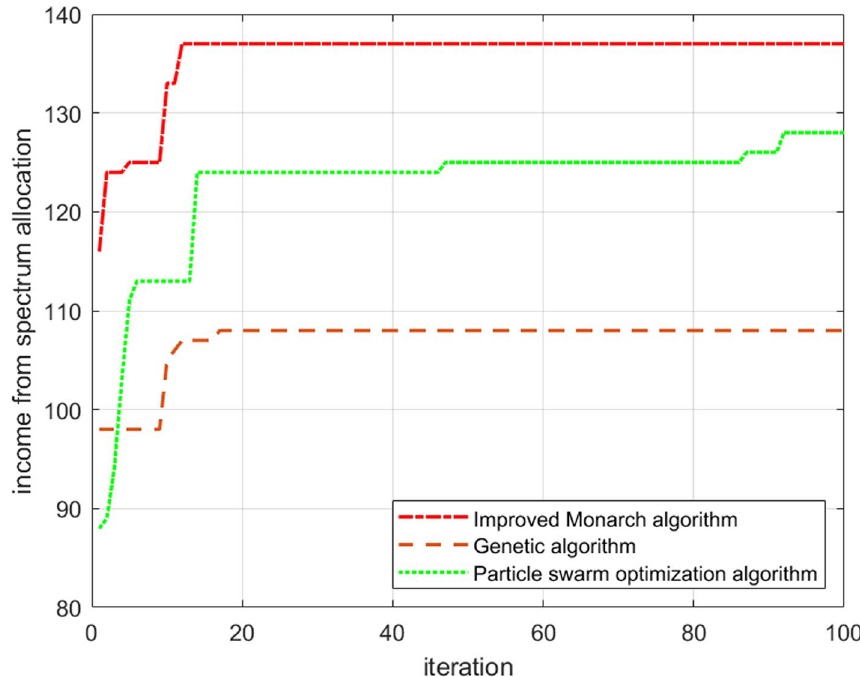
Fig. 5 Spectrum allocation income changes of the improved monarch butterfly algorithm, genetic algorithm and particle swarm optimization algorithm when T